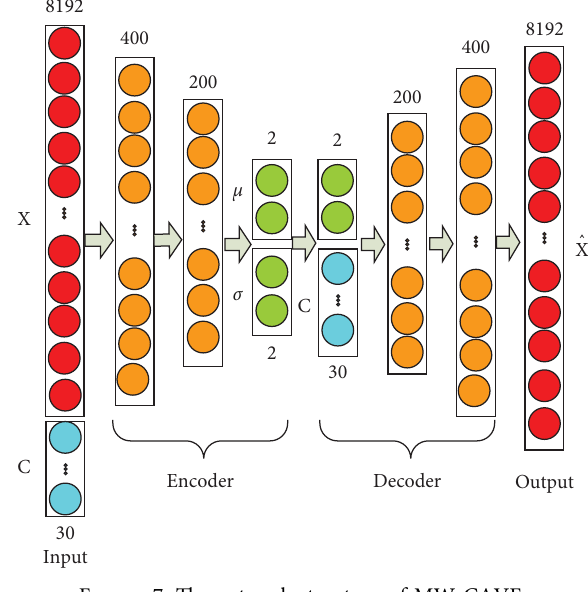
Figure 7: Te network structure of MW-CAVE.